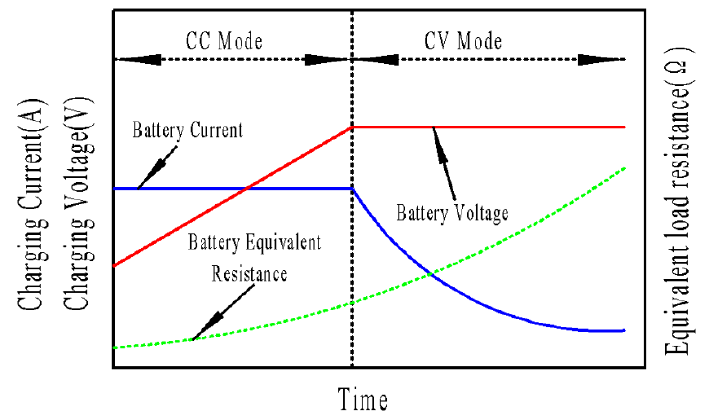
Figure 1. CC-CV charging curve of battery.